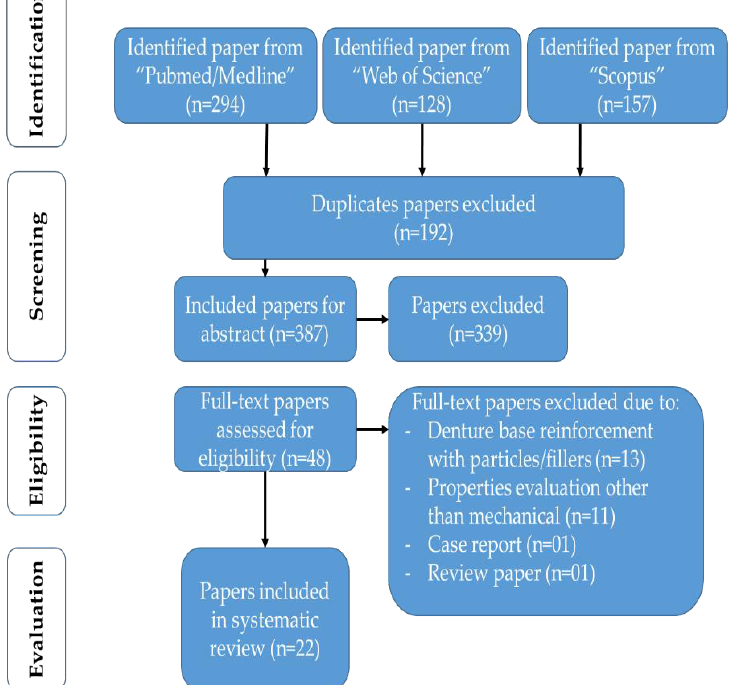
Figure 2. PRISMA flow chart of identified papers and their screening for inclusion in a systematic review.